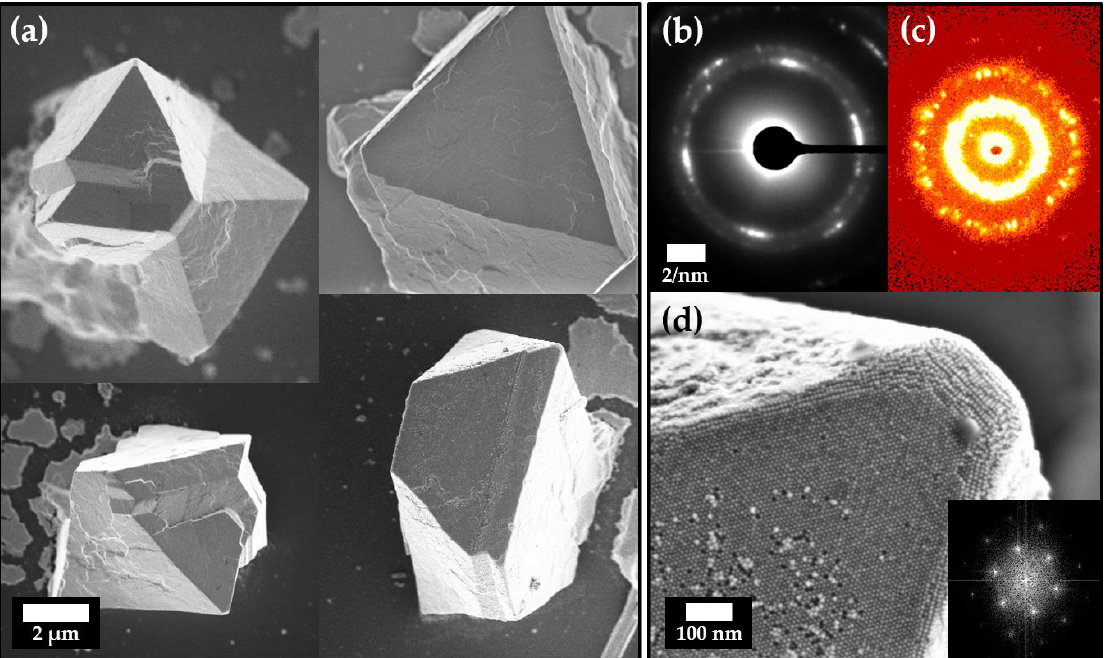
Figure 3. ( a ) FESEM images of various mesocrystals obtained from OLA-stabilized platinum nanocubes in hexane using the gas-phase diffusion technique with ethanol as the antisolvent. SAXS measurements Electron diffraction results ( b ) reveal a preferred crystallographic direction in which the individual particles orient. Together with SAXS measurements ( c ) of multiple mesocrystals, which show a high degree of particle ordering, it is evident that these superstructures are mesocrystalline. ( d ). The ordering on the surface appears to be hexagonal in at least one direction, which is confirmed by the FFT shown in the inset and in good agreement with previous findings by Li et al. [ 38 ].